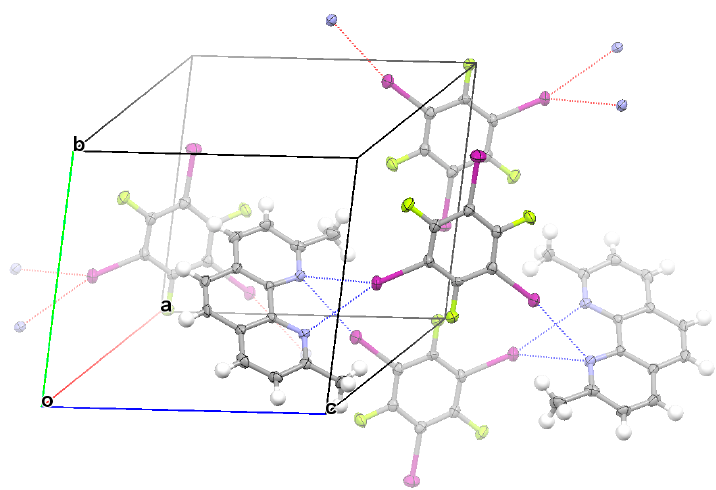
Figure 5. Part of the crystal structure of IV showing the formation of an asymmetrical bifurcated halogen bond, monocoordinate halogen bond, and π · · · π stacking interaction between two TFTIB molecules.